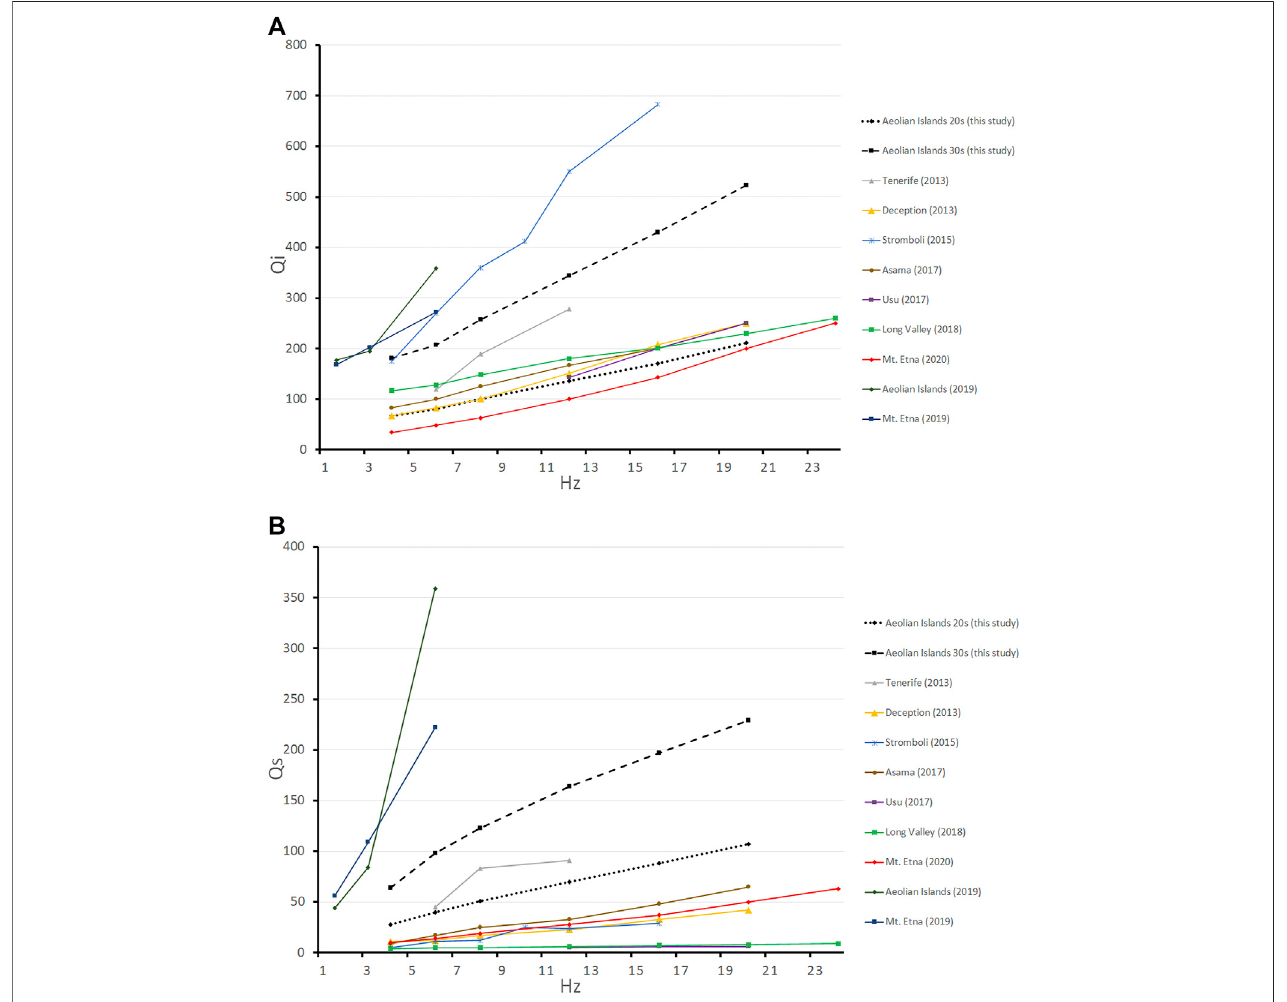
FIGURE 6 | Seismic attenuation for different volcanic regions. Comparisons of (A) Q i and (B) Q s for different regions using similar methodologies. The different resultswereobtainedfromthefollowingreferences:Tenerife(2013)fromPrudencioetal.(2013a);Deception(2013)fromPrudencioetal.(2013b);Stromboli(2015)from Prudencioetal.(2015c);Asama(2017) fromPrudencioetal.(2017a);Usu(2017)fromPrudencioetal.(2017b);LongValley(2018) fromPrudencioetal.(2018);Mt.Etna (2019) and Aeolian Islands (2019) from Del Pezzo et al. (2019); Mt. Etna (2020) from Ibáñez et al.